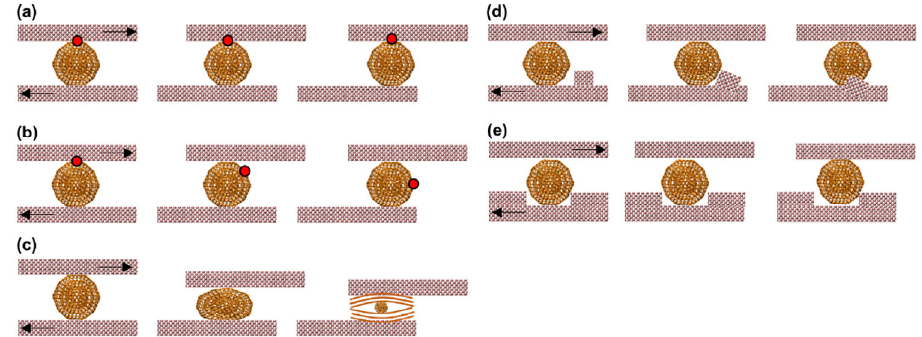
Fig. 6 Schematic showing the potential mechanisms of friction reduction by the presence of nanoparticle additives pressed between sliding metal surfaces, adapted from Ref. [257]. (a) Sliding, (b) rolling, (c) exfoliation, (d) polishing, and (e)